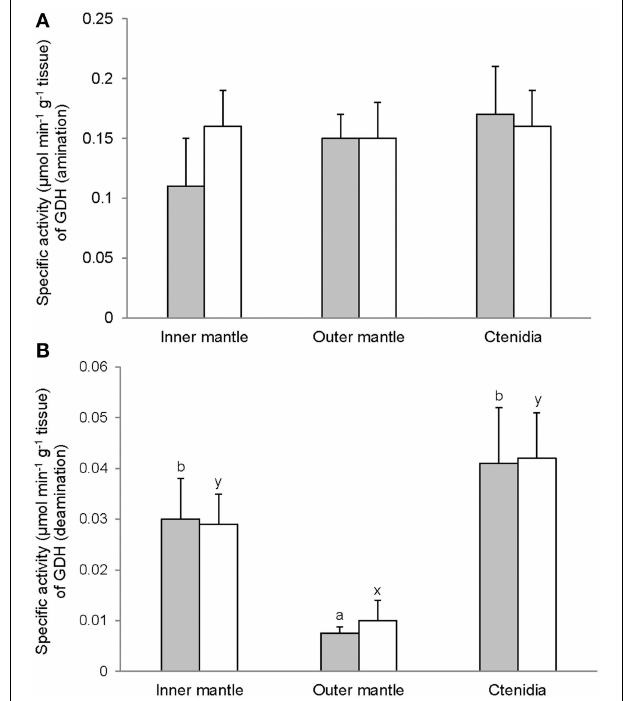
FIGURE 9 | Mass-specific activity ( µ mol Pi min − 1 g − 1 tissue + S.E.M.; N = 4 ) of glutamate dehydrogenase (GDH) in (A) the amination direction and (B) the deamination direction from the inner mantle, the outer mantle, and ctenidia of Tridacna squamosa exposed to 12h of darkness (control; closed bar) or 12h of light (open bar). Values represent means + S.E.M. ( N = 4 ). Means not sharing the same letter (a, b for darkness, or x, y for light) are significantly different from each other ( P < 0 . 05